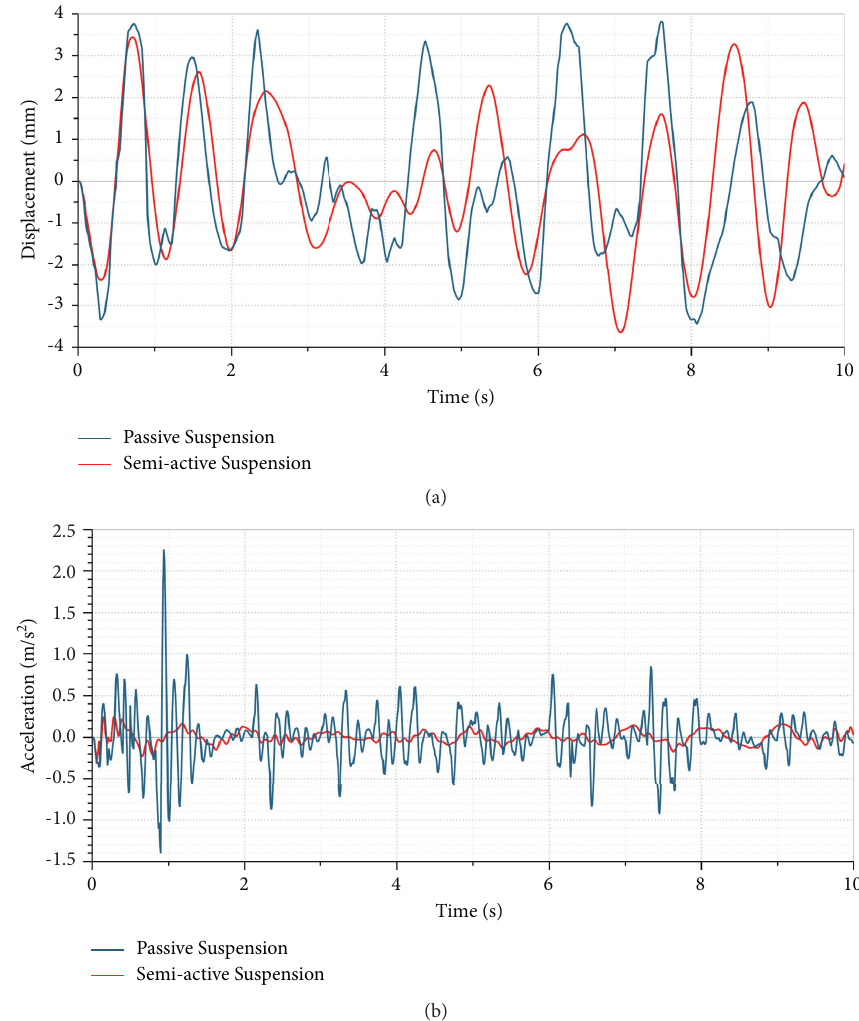
Figure 9: Simulation curve of dynamic characteristics of magnetoelectric hybrid suspension. (a) Displacement curve. (b) Acceleration